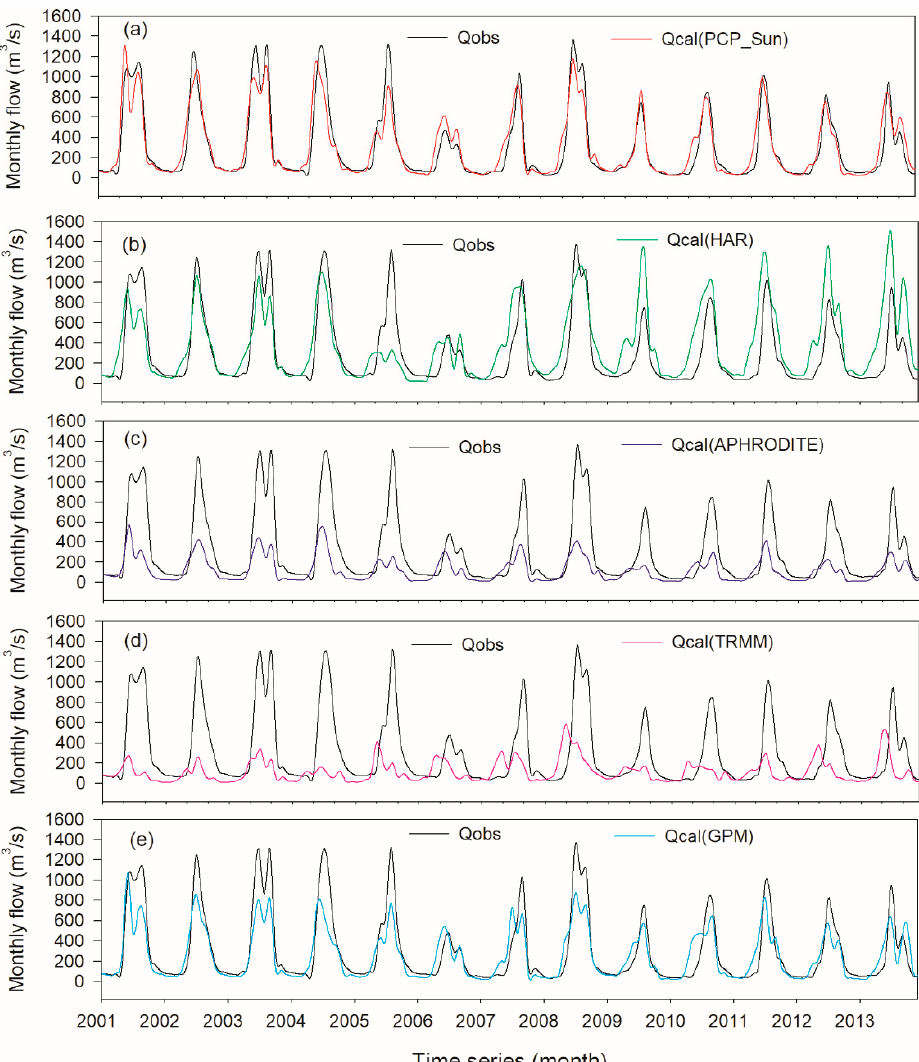
Figure 12. Monthly flow simulation driven by ( a ) reference precipitation and four precipitation